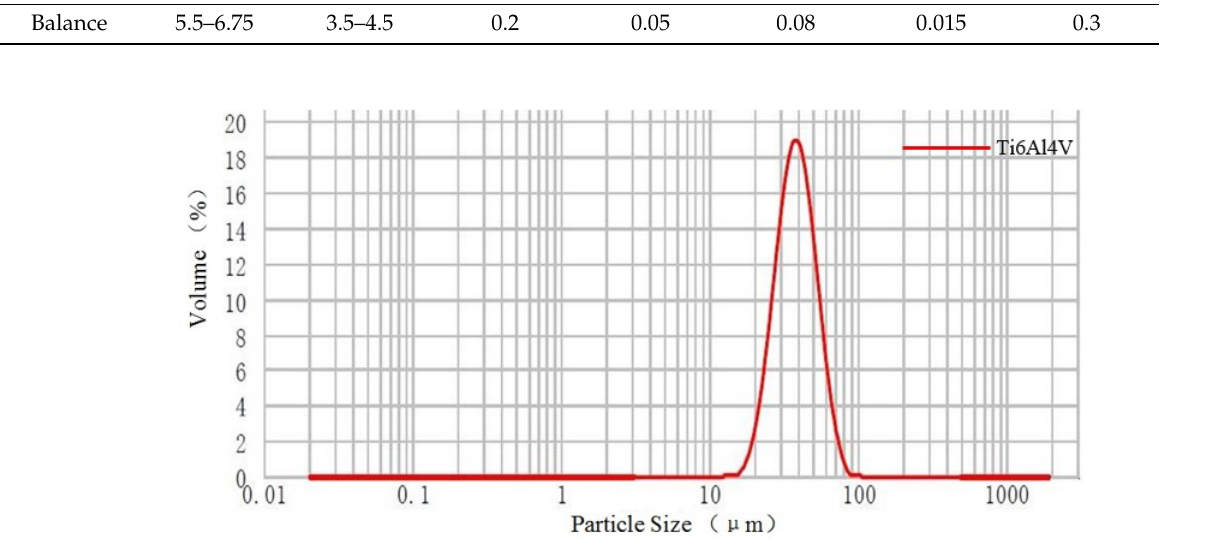
Figure 7. Morphology of Ti6Al4V powder material. Table 2. Nominal chemical compositions of gas-atomized powder material of Ti6Al4V alloy (wt%). Element